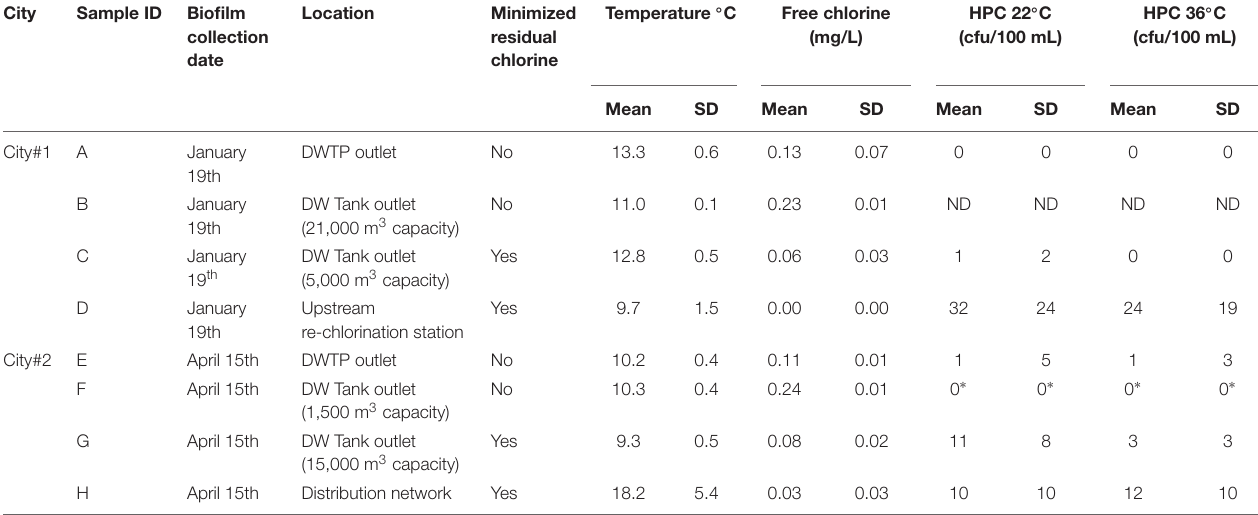
TABLE 1 | Water quality parameters during biofilm formation.